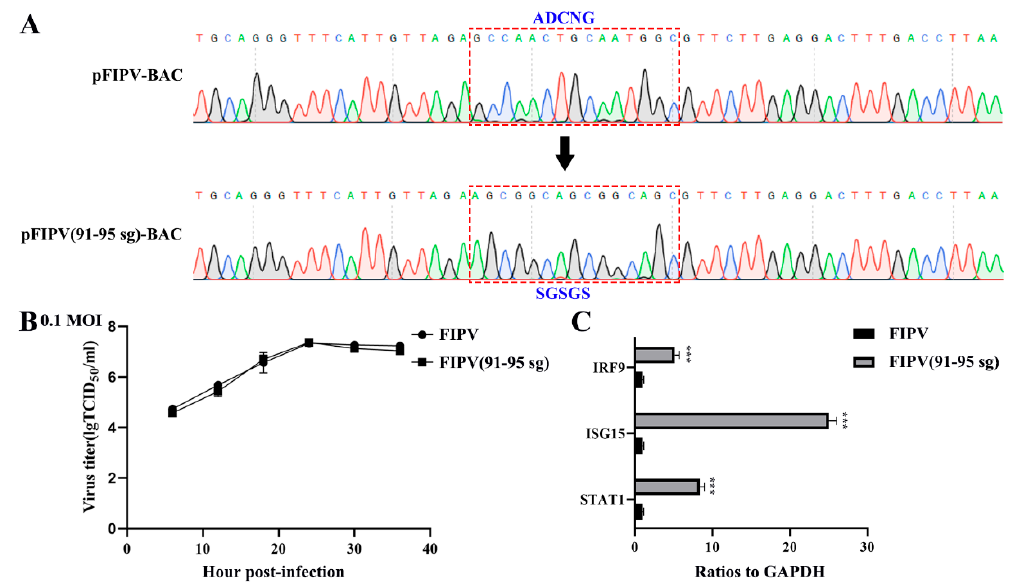
Figure 6. Quantitative real-time PCR analysis of FIPV or FIPV (91–95 sg) infectious clone in CRFK cells. ( A ) Sequence analysis of the targeted mutation area between pFIPV-BAC (pBeloBAC11) and pFIPV (91–95 sg)-BAC by RT-PCR sequencing. (B) Growth curves with the wild-type viruses FIPV and FIPV (91–95 sg) with an original multiplicity of infection (MOI) of 0.1. ( C ) Quantitative real-time PCR analysis of selected mRNAs (STAT1, IRF9, and ISG15) for FIPV or FIPV (91–95 sg) treated in CRFK cells. The data are presented as the means ± standard deviation (SD) ( n = 3). Asterisks indicate statistical significance as determined by Student’s t-test. ***, p < 0.001.